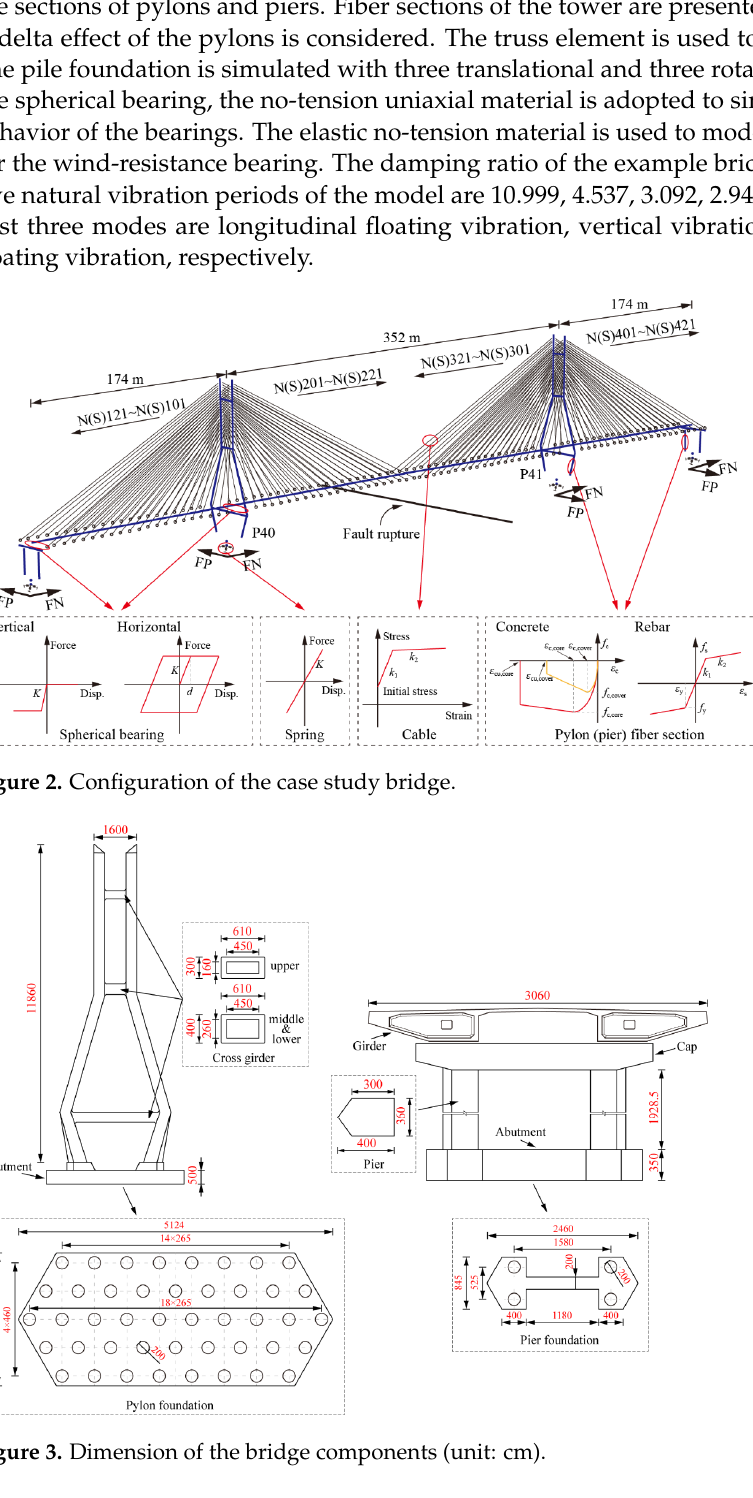
Figure 4. Fiber sections of the pylon (unit: cm). Material uncertainties are considered for the numerical model of the bridge. In addi- tion, the uncertainty of the actual initial cable forces due to the construction error is also considered. In this study, the compressive strength of the concrete ( f c ), yield strength of the rebar ( f y ), initial stiffness of the rebar ( E ), the ratio between the post-yield and initial stiffness, and the ratio between actual and designed initial cable forces ( R ) are modeled as